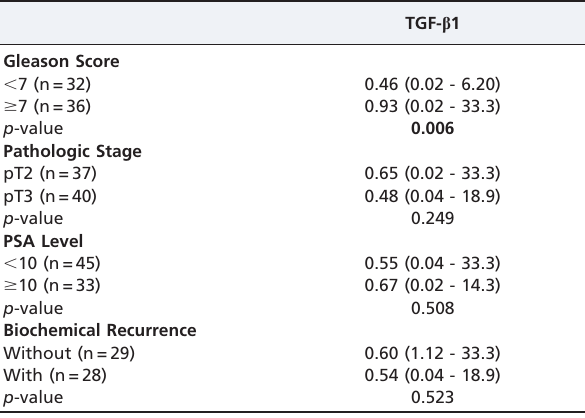
Table 2 - Relative expression of the TGF- b 1 gene in the malignant prostatic tissues according to Gleason score, pathologic stage, PSA level and biochemical recurrence. Fold changes in gene expression were calculated using the DD CT method (QRel = 2 - DD CT